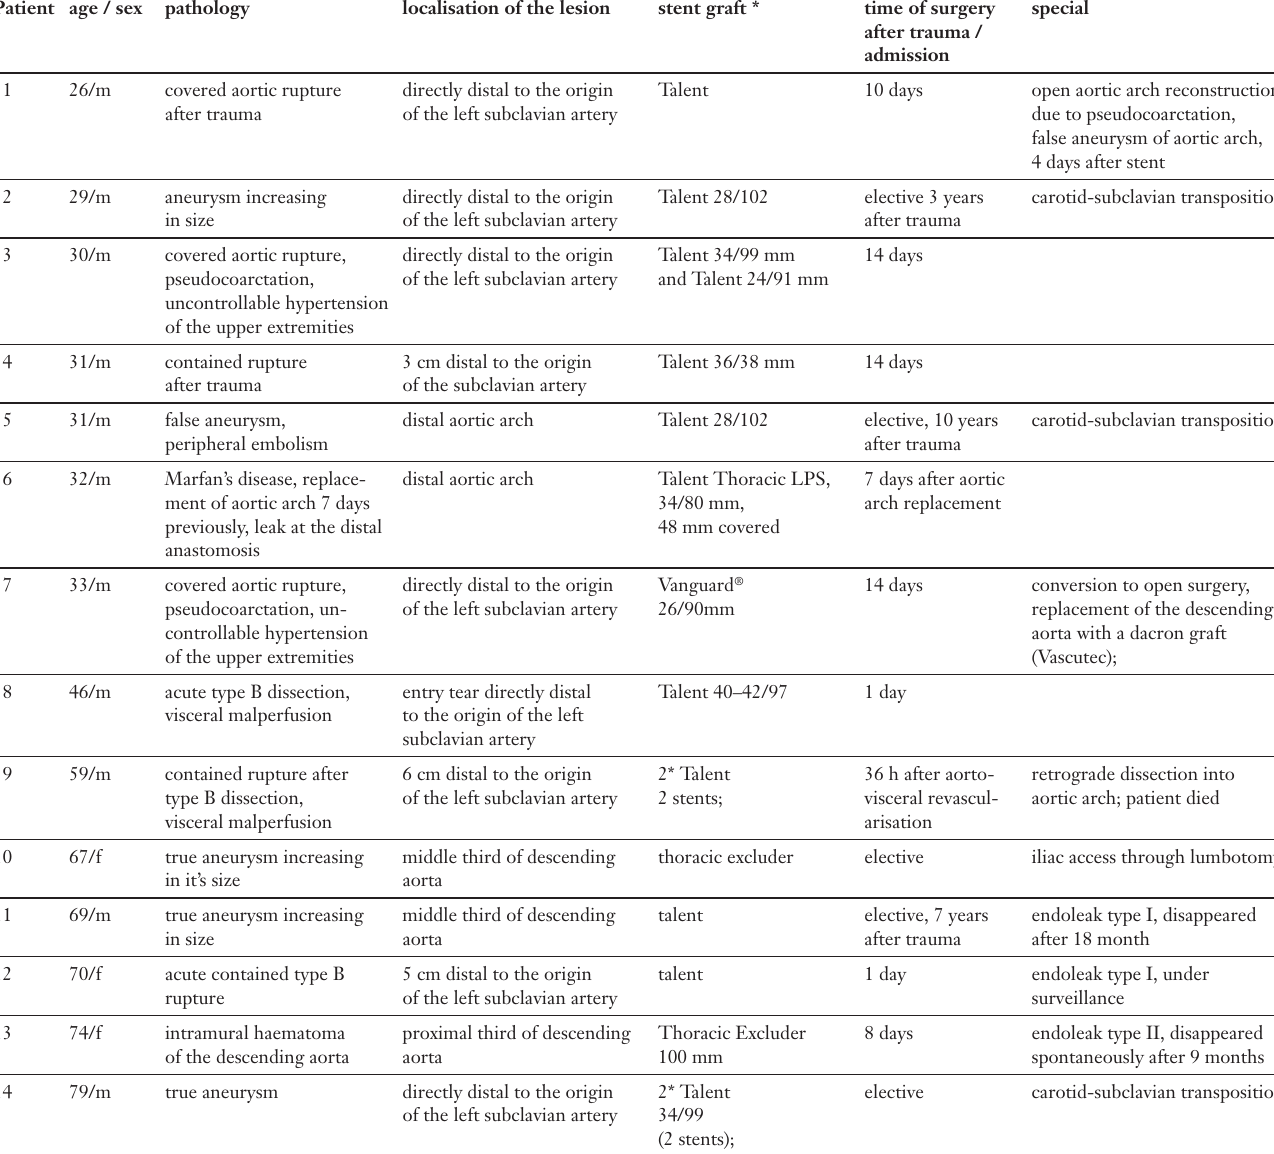
Table 1 Underlying pathologies and patient